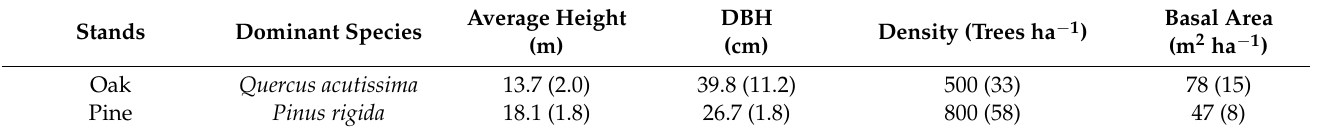
Table 2. The forest structure of oak and pine stands in the experimental forest at Chungnam National University, South Korea. Parentheses are standard errors of the mean ( n = 5). Average Height Stands Dominant Species Oak Quercus acutissima Pine Pinus